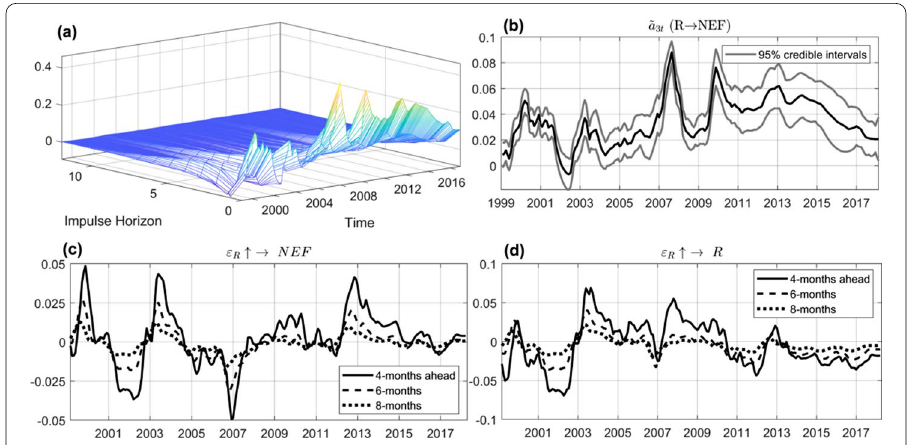
Fig. 5 Time-varying impulse responses of NEF. a) The historical impulse response functions of net flows b) The contemporaneous response of net flows c) Time-varying response of net flows to return shocks at specific horizons d) Time-varying response of returns to return shocks at specific horizons. These results are from the estimation of TVP-VAR-SV with ordering the variables as follows: { EPU , R , NEF }